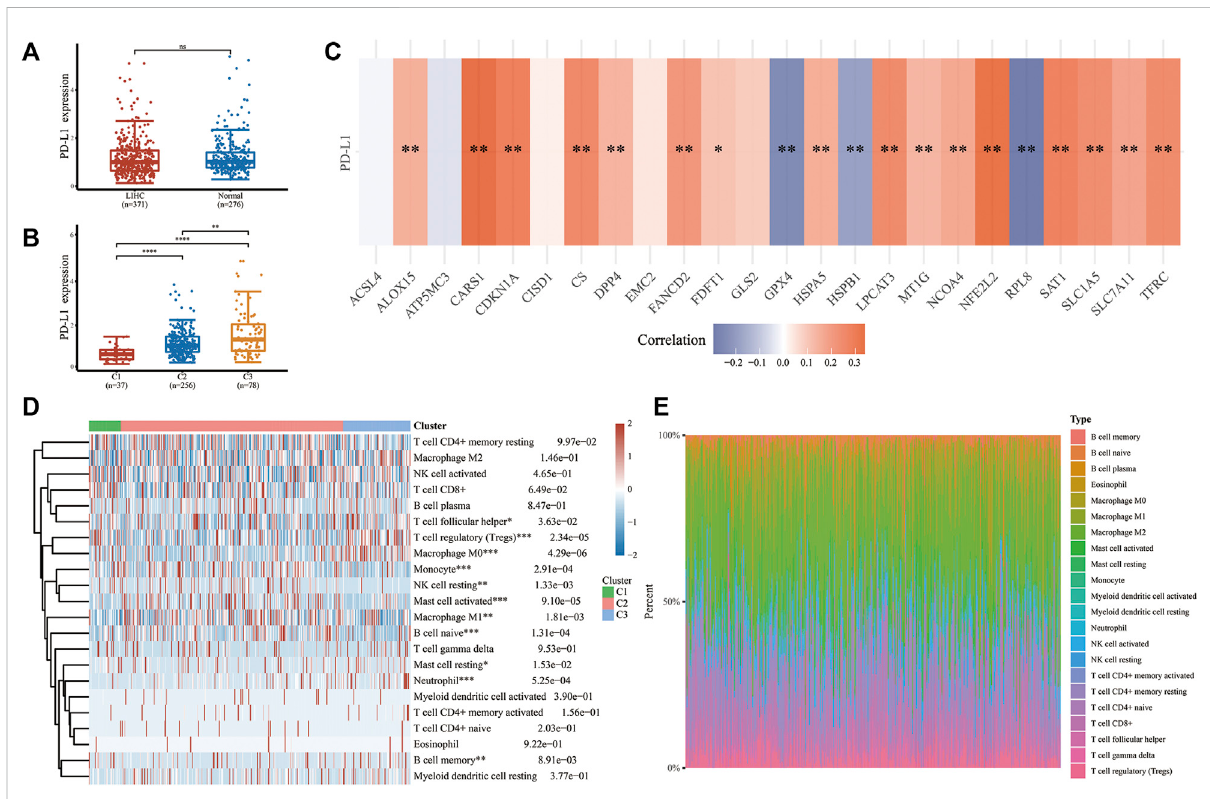
FIGURE 3 The relationship betweenPD-L1 and FRGsand the immune in fi ltration landscape of three subtypes inLIHC. (A,B) The expression differences of PD-L1 in LIHC and normal tissues and among different subtypes. (C) Correlation between PD-L1 and selected FRGs in TCGA cohort of LIHC. (D) Heatmapandproportionalplottinggraph (E) ofimmunecellabundancewithinthreesubtypes.* p < 0.05,** p < 0.01,*** p < 0.001,and ***p <